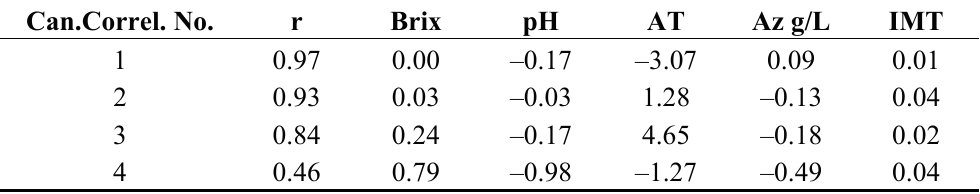
Table 7. CCA coefficients of the first four canonical correlations for red musts of 2012. Can.Correl. No.